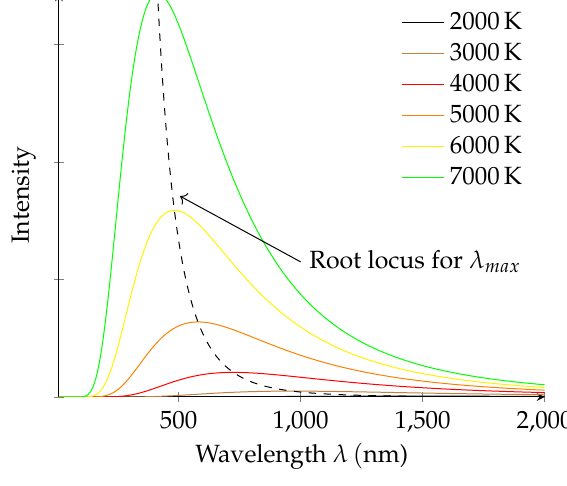
Figure 4. Black body radiation law curves for different temperatures. For the highest temperature 7000K, the intensity peak is high and sharp, while it tends to level out for lower temperatures as for the case of